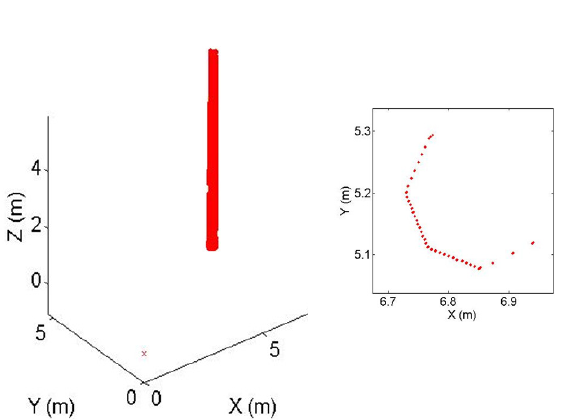
Figure 7. A lamp pole was captured with the Velodyne HDL-32E on the University of Calgary Campus